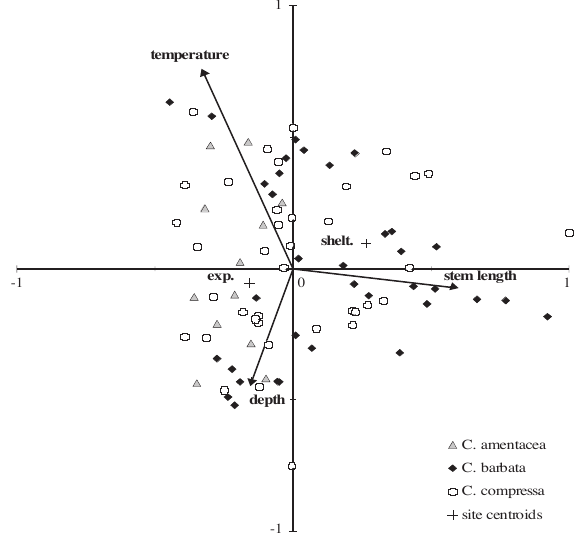
F IG . 4. – Ordination of faunal samples for Cystoseira amentacea , C. barbata and C. compressa using Analysis of Canonical Correspon- dence with environmental variables. x and y are the first two CCA axes. Arrows show direction and rates of variation among samples in water temperature, water depth and algal stem length. The sheltered and exposed sites are shown by their centroids (P = 0.001).